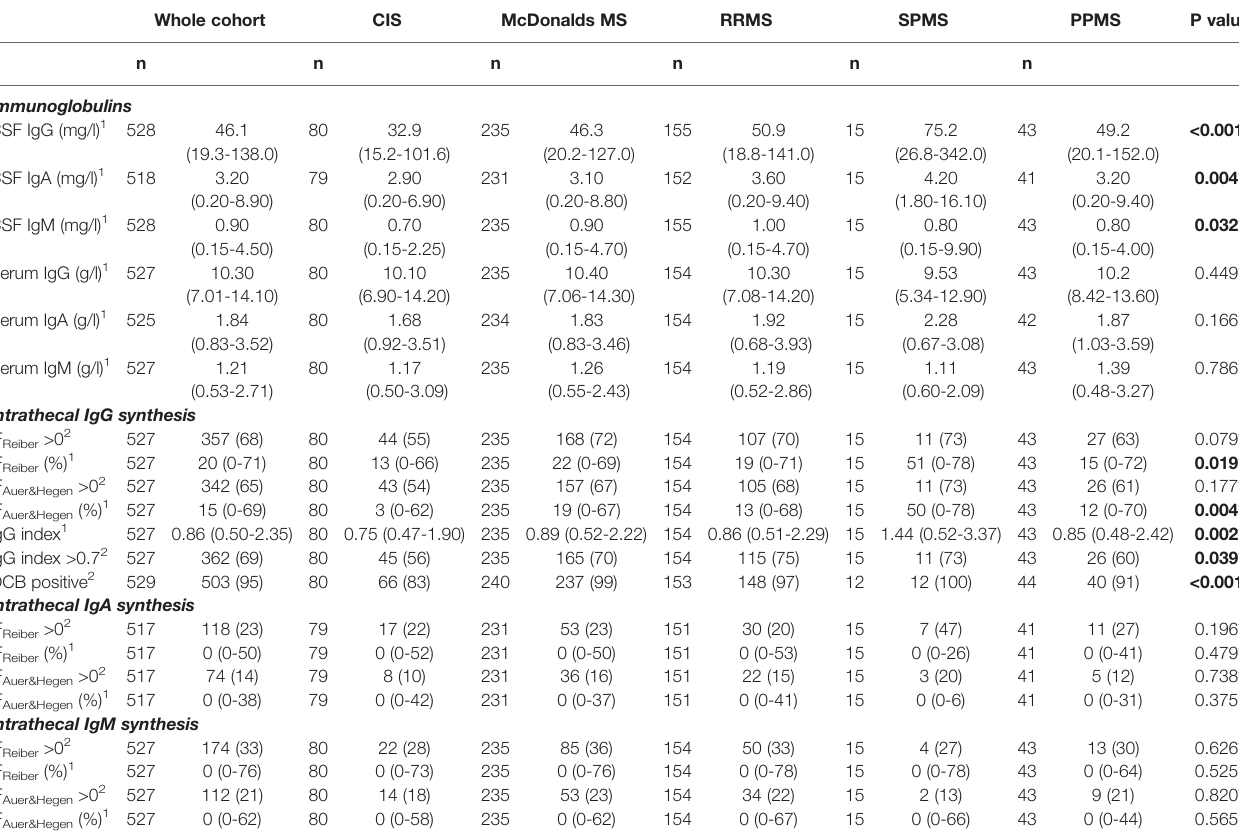
TABLE 1B | Cerebrospinal fl uid fi ndings in multiple sclerosis and according to different disease courses: Intrathecal Ig synthesis. Whole cohort